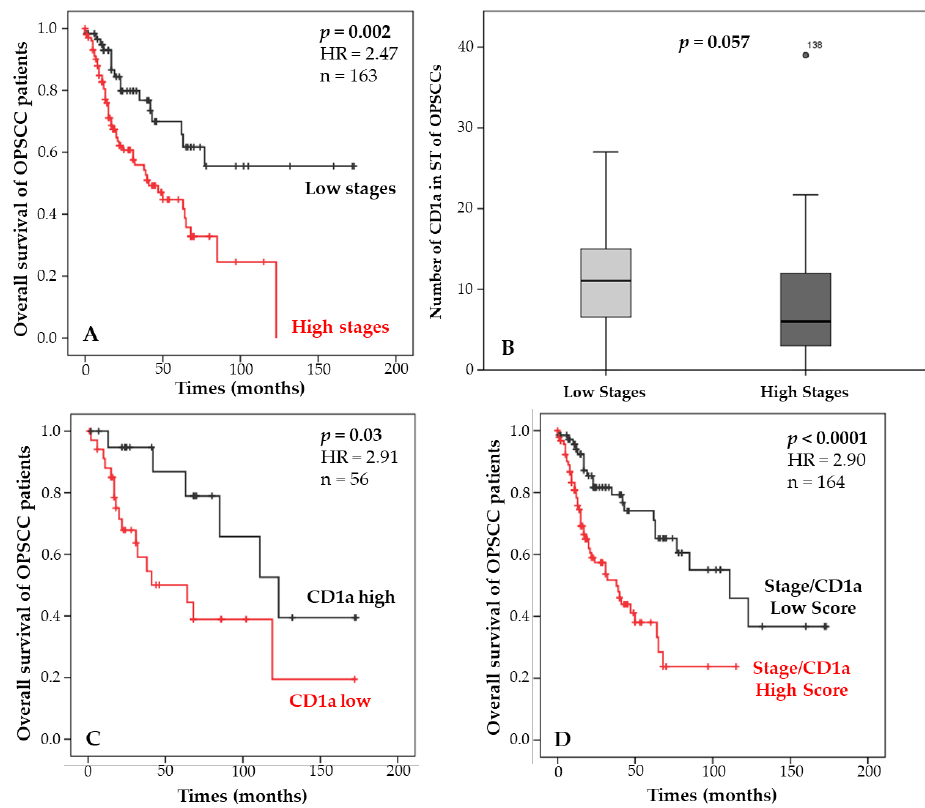
Figure 4. Kaplan–Meier curves of the OS of OPSCC patients according to staging ( A ), the number of CD1a+ cells infiltrating the ST ( C ), and the score combining the staging and CD1a density ( D ). Mann–Whitney test illustrating the number of CD1a cells in the ST of OPSCC patients according to the staging (low (I/II) versus high (III/IV) stages, as described in the TNM staging system 8) ( B ). As described in Table 6, a combination was established between these two clinical and immune variables according to their prognostic performance. When the eighth version of the TNM was created, high-stage p16+ patients were downgraded from one group to another due to their favorable prognosis. In the same manner, we observed that high-stage patients with initially poor survival had a significantly improved prognosis when they had a high density of Langerhans cells. Based on this observation, these patients were grouped with low-stage patients to create a prognostic score (low versus high). This score was tested in relationship to OS and showed a significantly better survival for patients with a low score compared with those with a high score ( p < 0.0001, Figure 4D). This result highlights a higher significance than stage or CD1a density used